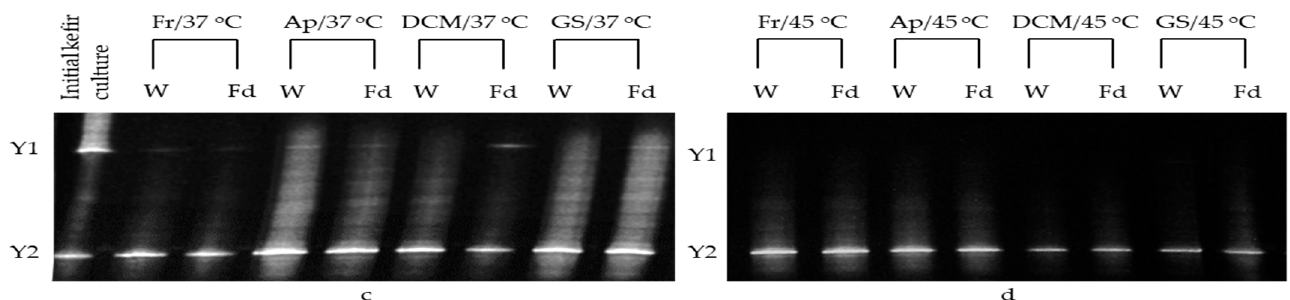
Figure 1. DGGE bacterial ( a , b ) and eukaryotic ( c , d ) fingerprint representing PCR-amplified 16S rRNA and 26S rRNA, respectively, from total community DNA derived from wet or freeze-dried free or immobilized kefir culture after semi-dry and sweet low alcohol wine-making at high temperatures (37 and 45 °C). For each sample, two replicate profiles from two independent nucleic acid extracts were analyzed and compared to free kefir culture (prior to use in fermentations). Fr: Free kefir culture, Ap: Immobilized kefir culture on apple pieces, DCM: Immobilized kefir culture on DCM, GS: Immobilized kefir culture on grape skins. W: Wet, Fd: Freeze-dried. The fermentation temperature is shown after the sample codes. Y1 band: Kluyveromyces marxianus / Kluyveromyces lactis, Y2 band: Saccharomyces cerevisiae , B1 band: Lactobacillus helveticus / Lactobacillus dextrinicus , B2/B3 band: Lactobacillus buchneri / Lactobacillus kefiri / Lactobacillus sunkii .